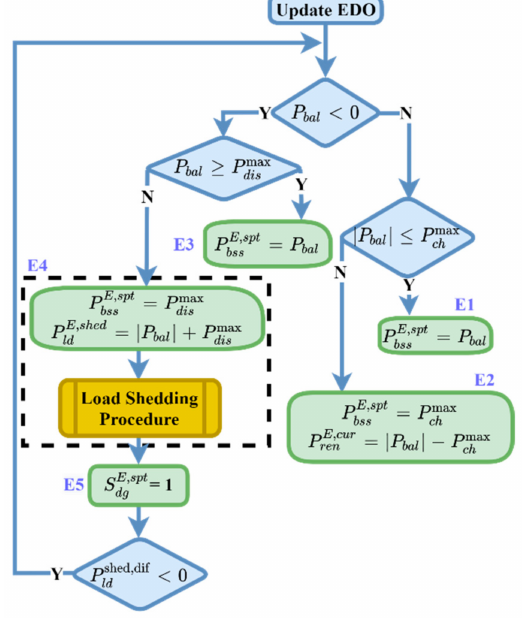
Figure 12. Emergency dispatch order calculation flowchart.